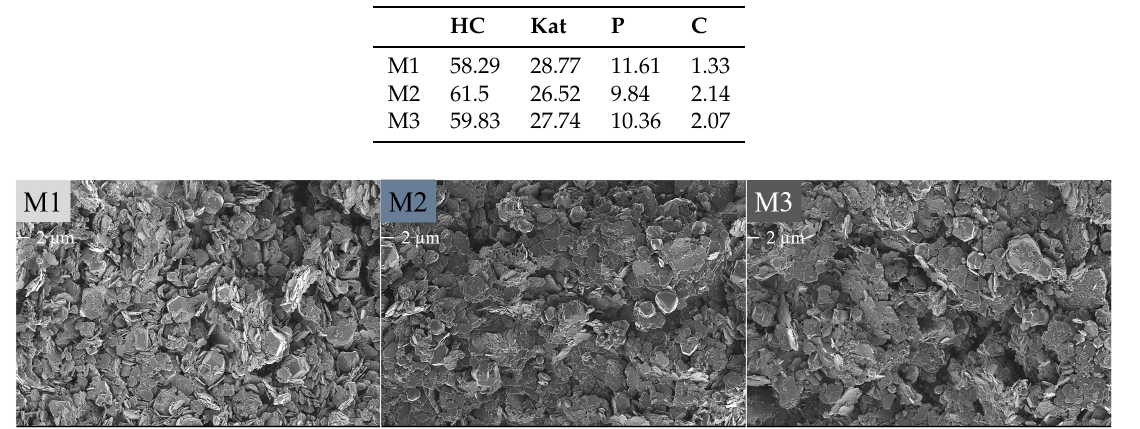
Figure 20. SEM micrographs of the mixing series M1 = 500rpm, M2 = 750rpm and M3 = 1000rpm taken at 1keV and 2k magnification. The scale bar is indicated below the